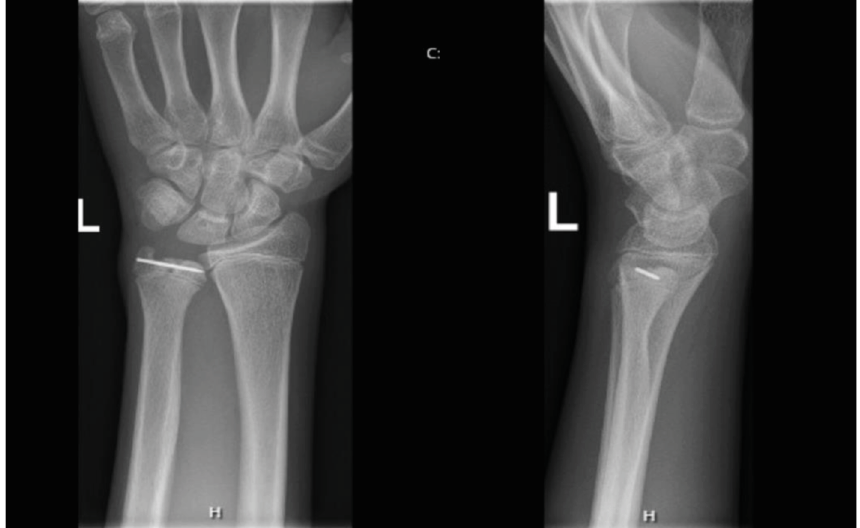
Figure 4: Anteroposterior and lateral X-ray 6 months after surgery. Two pins have been removed. No physeal closure